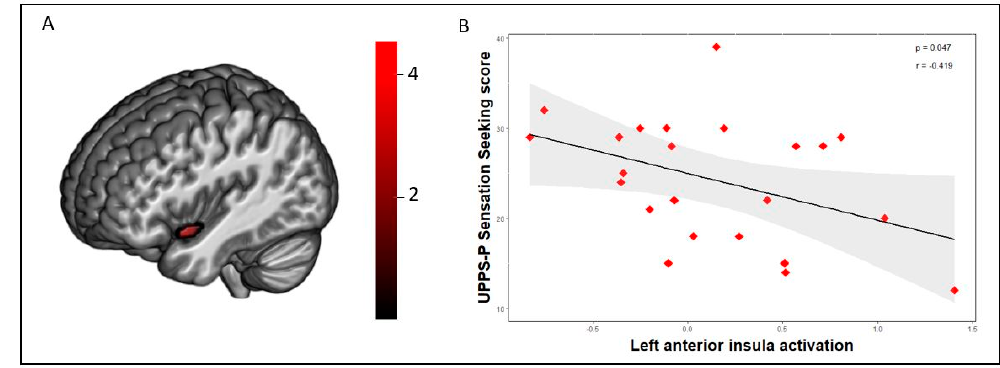
Figure 1. ( a ) Increased activation was found in the left anterior insula in the healthy control group in comparison to the obesity group (AlphaSim voxel level probability = p < 0.001, p < 0.05 familywise error (FWE) cluster-extent corrected) during the losses vs. wins contrast of the Risky Gains Task. Color bar represents t-values. ( b ) A scatterplot depicting the negative association between extracted activation eigenvalues from the left anterior insula peak (losses vs. wins) and UPPS-P sensation seeking scores in the obesity group [ n = 23, r (23) = − 0.419, p = 0.047]. Table 2. fMRI Risky Gains Task Results for Group by Outcome Interactions. MNI